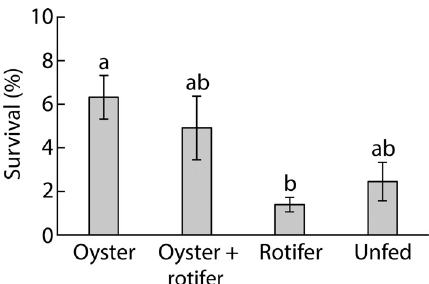
Fig. 4. Effect of diet on survival of Paracanthurus hepatus to 5 days post-hatch. Data are means ± SE, n = 3. Bars with the same letters are not significantly different according to 1-way ANOVA followed by Tukey’s HSD test (p < 0.05)